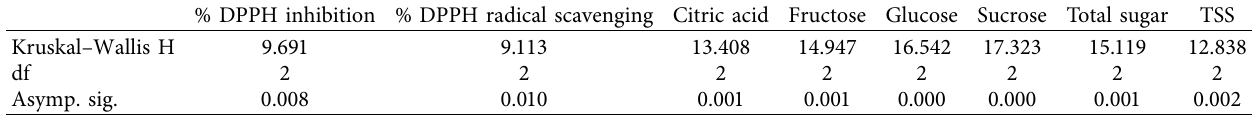
Table 5: Kruskal–Wallis H test results.